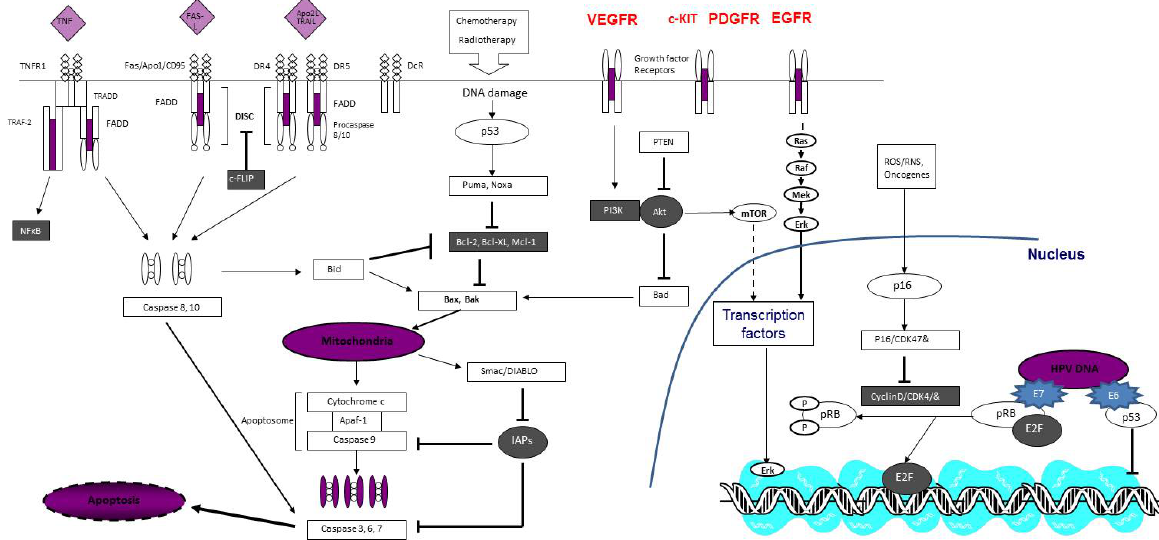
Figure 1. Schematic diagram illustrating molecular pathways implicated in penile cancer (diagram has been modified and replicated with the explicit permission of Expert Opin.